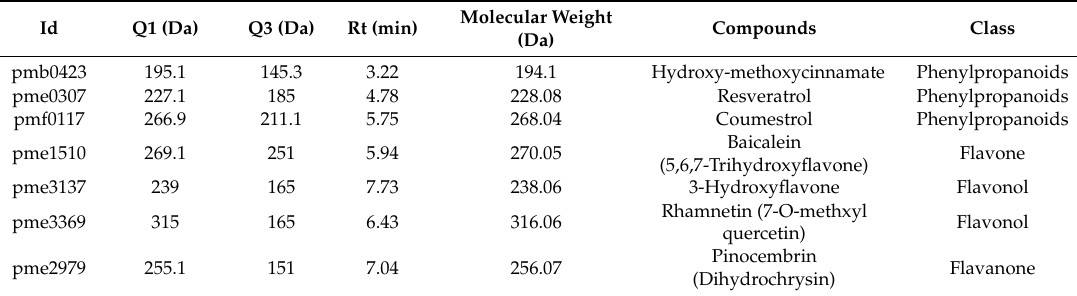
Table 1. A list of HWZ-specific metabolites.